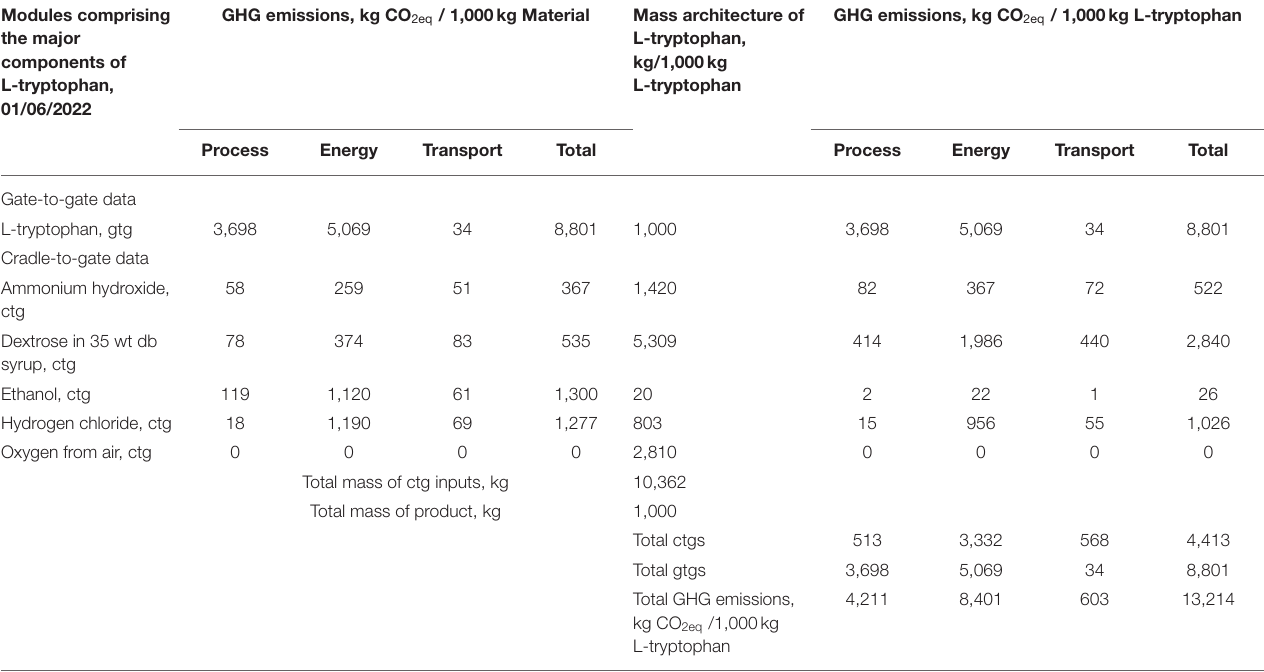
TABLE 3 | Greenhouse gas emissions for L-tryptophan cradle-to-gate (ctg). Modules comprising the major components of L-tryptophan, 01/06/2022